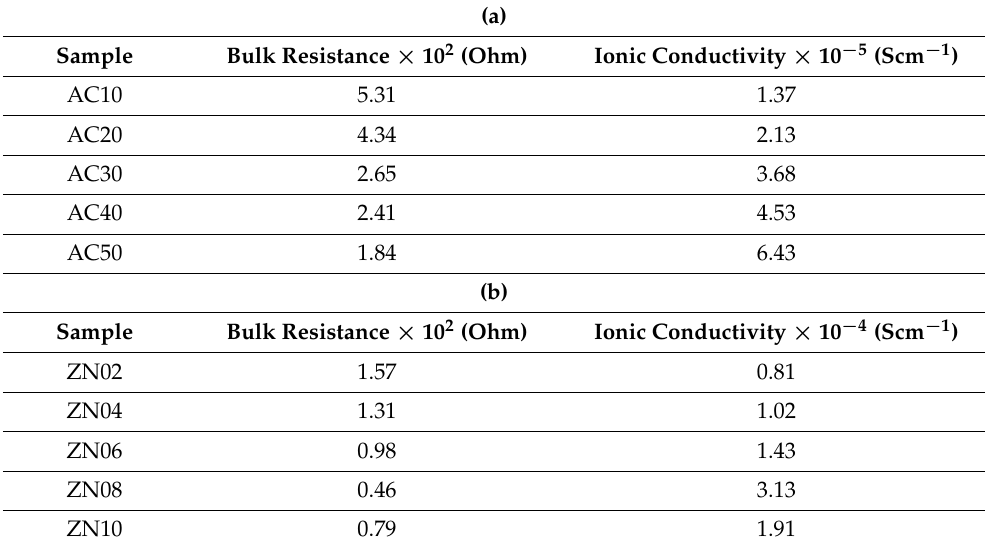
Table 1. Upper half: Ionic conductivity of MC/PC/NH 4 Cl SPEs. Bottom half: Ionic conductivity of MC/PC/NH 4 Cl/ZnO